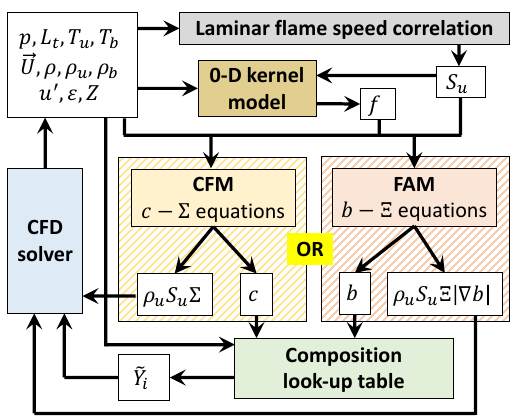
Figure 2. Schematic of the CFM and FAM combustion models embedded into the same numeri- cal